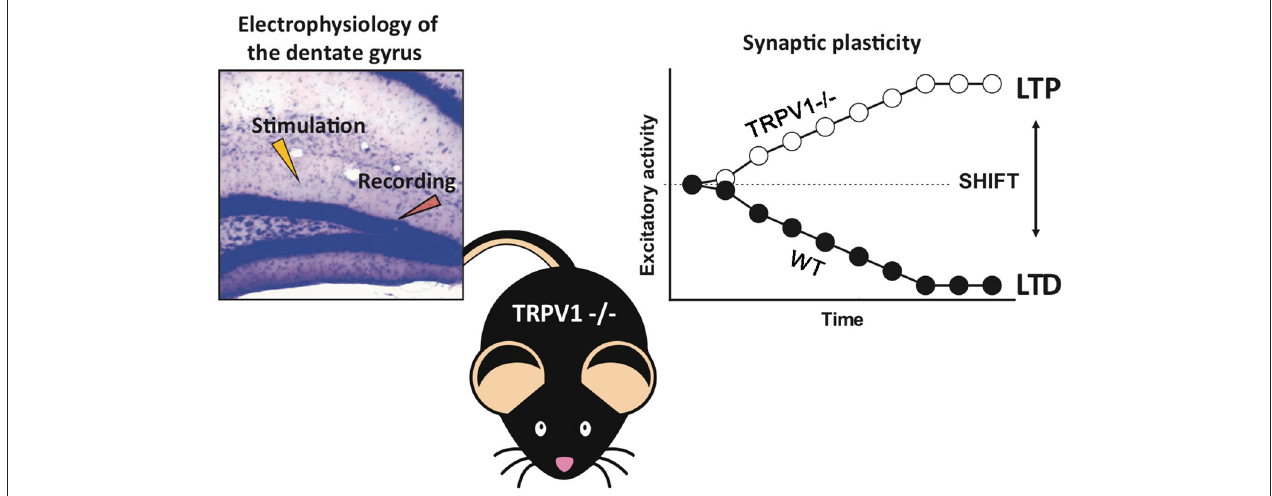
FIGURE 5 | Summary of the main findings. The absence of TRPV1 shifts the cannabinoid CB 1 receptor-dependent long-term depression to long-term potentiation at the excitatory medial perforant path–granule cell synapses in the mouse dentate molecular layer.